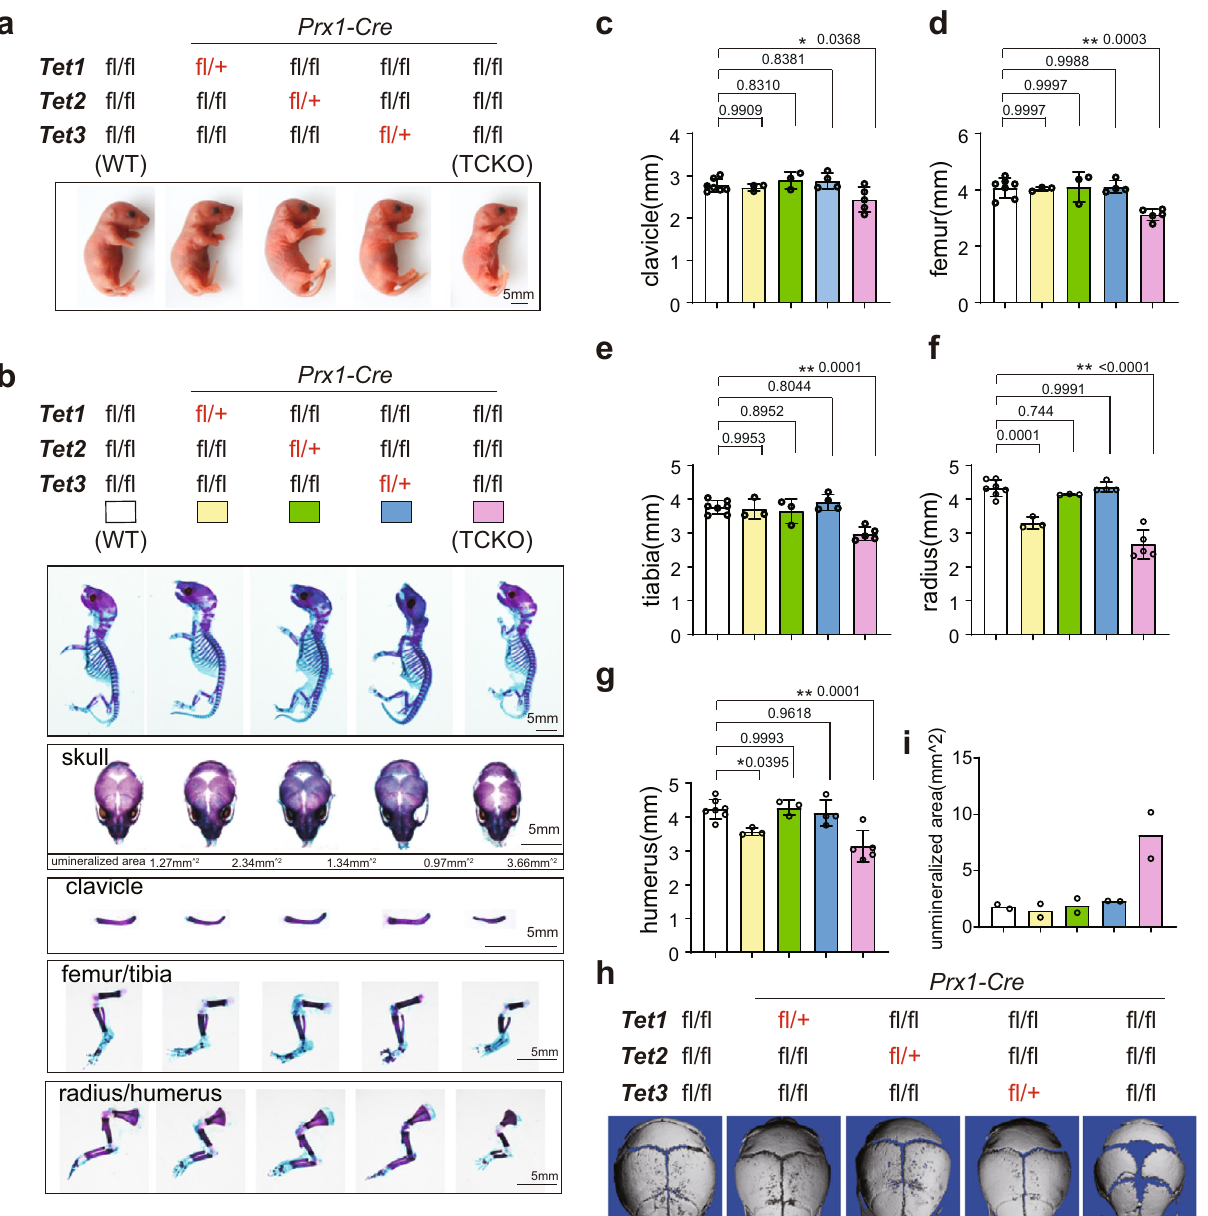
Fig.1|Lossof Tet familygenesleadstocleidocranialdysplasia-likephenotype. a Gross images of indicated genotype mice. Scale bar=5mm. b The whole mount skeleton staining of WT and indicated genotype mice by Alcian blue and Alizarin redSatpostnatalday0(P0).Thequanti fi cationdataoftheunmineralizedareawas annotated below the cranial bones. scale bar=5mm. c – g Quanti fi cation of the length of clavicle ( c ), femur ( d ), tibia ( e ), radius ( f ), and humerus ( g ) of indicated genotype mice. * P <0.05, ** P <0.01. Ordinary one-way ANOVA. Data are presented